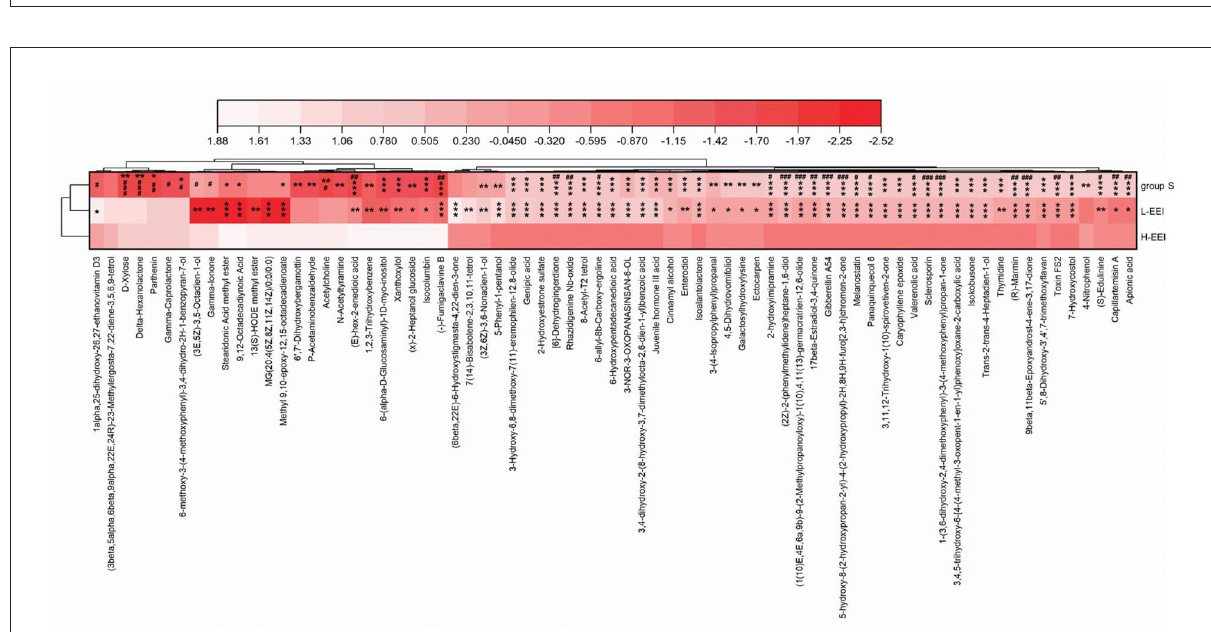
FIGURE5 Differential metabolites among the three groups based on LC-MS data of feces. Darker colors indicate lower metabolite abundance, while lighter colors indicate higher metabolite abundance. The Kruskal–Wallis H test compares multiple groups, followed by the Scheffe post-hoc tests for metabolites with P < 0.01. n = 6 in each group, * P < 0.05, ** P < 0.01, *** P < 0.001, compared with group S; # P < 0.05, ## P < 0.01, ### P < 0.001, compared with the